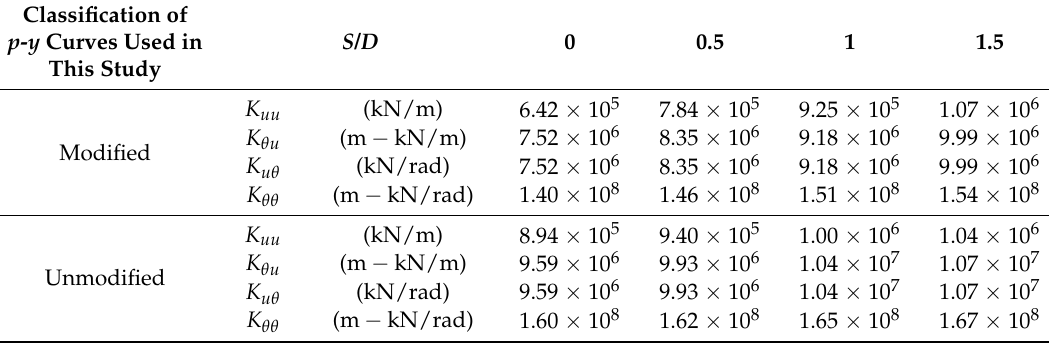
Table 4. The foundation stiffness matrix used in